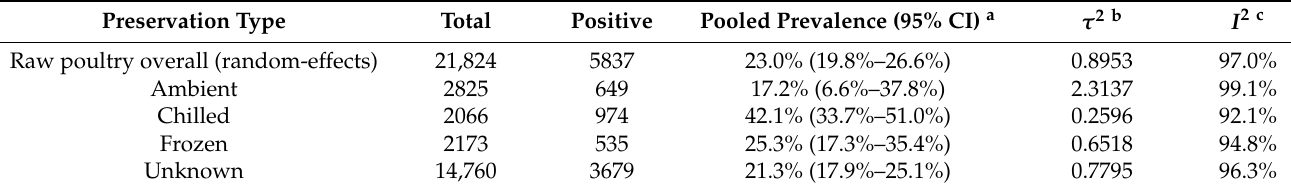
Table 2. Meta-analysis results for mean prevalence of Salmonella in poultry by preservation type based on the included